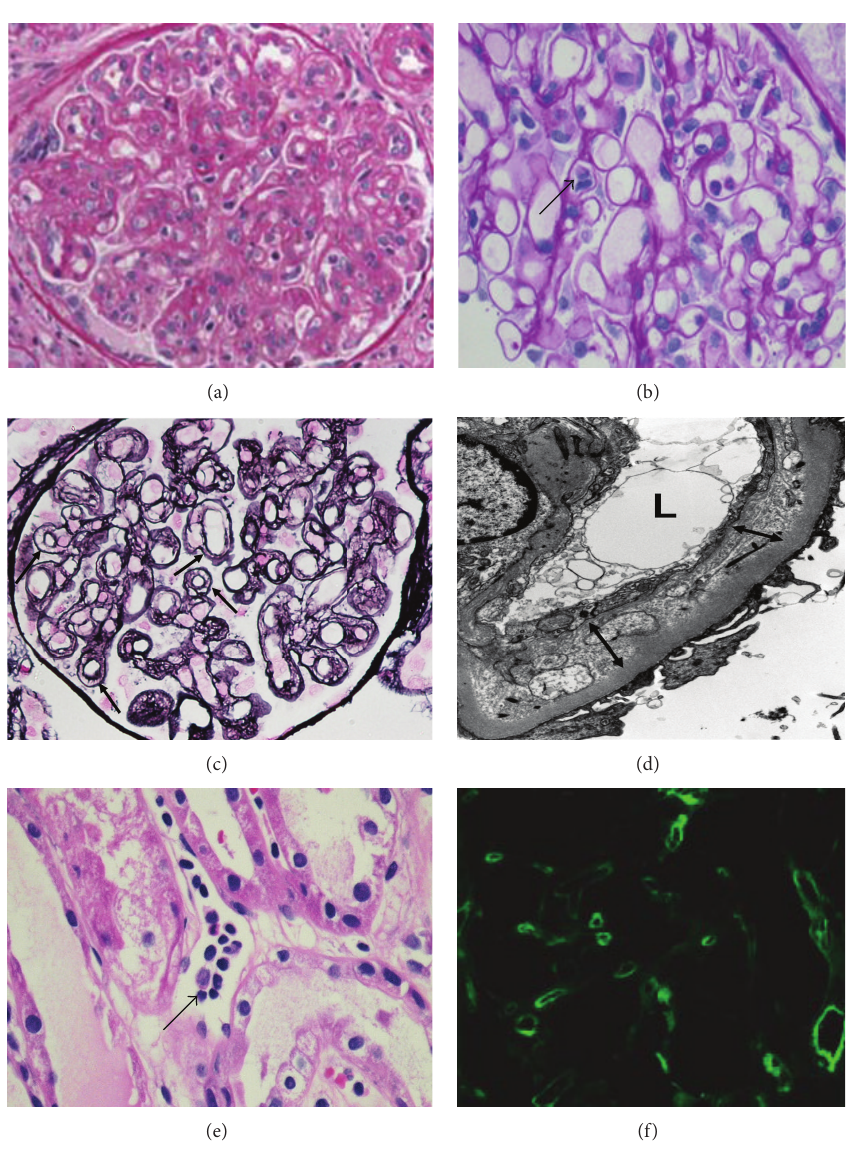
Figure 1: Histopathology of transplant glomerulopathy. (a) Light microscopy showing TG with a glomeruli showing sclerosis (periodic-acid- Schiff stain × 400). (b) Light microscopy showing glomerulitis (presence of mononuclear cells in glomerular capillaries) in a biopsy specimen (periodic-acid-Schiff stain × 600) (c) Silver staining highlighting double contouring of the glomerular capillary wall ( × 400). (d) Electron microscopy showing duplication of the glomerular basement membrane—arrows ( × 8000) (e) Peritubular capillitis (arrow) in a TG biopsy specimen (periodic-acid-Schiff × 600) (f) Peritubular C4d staining in a TG biopsy (immunofluorescence ×